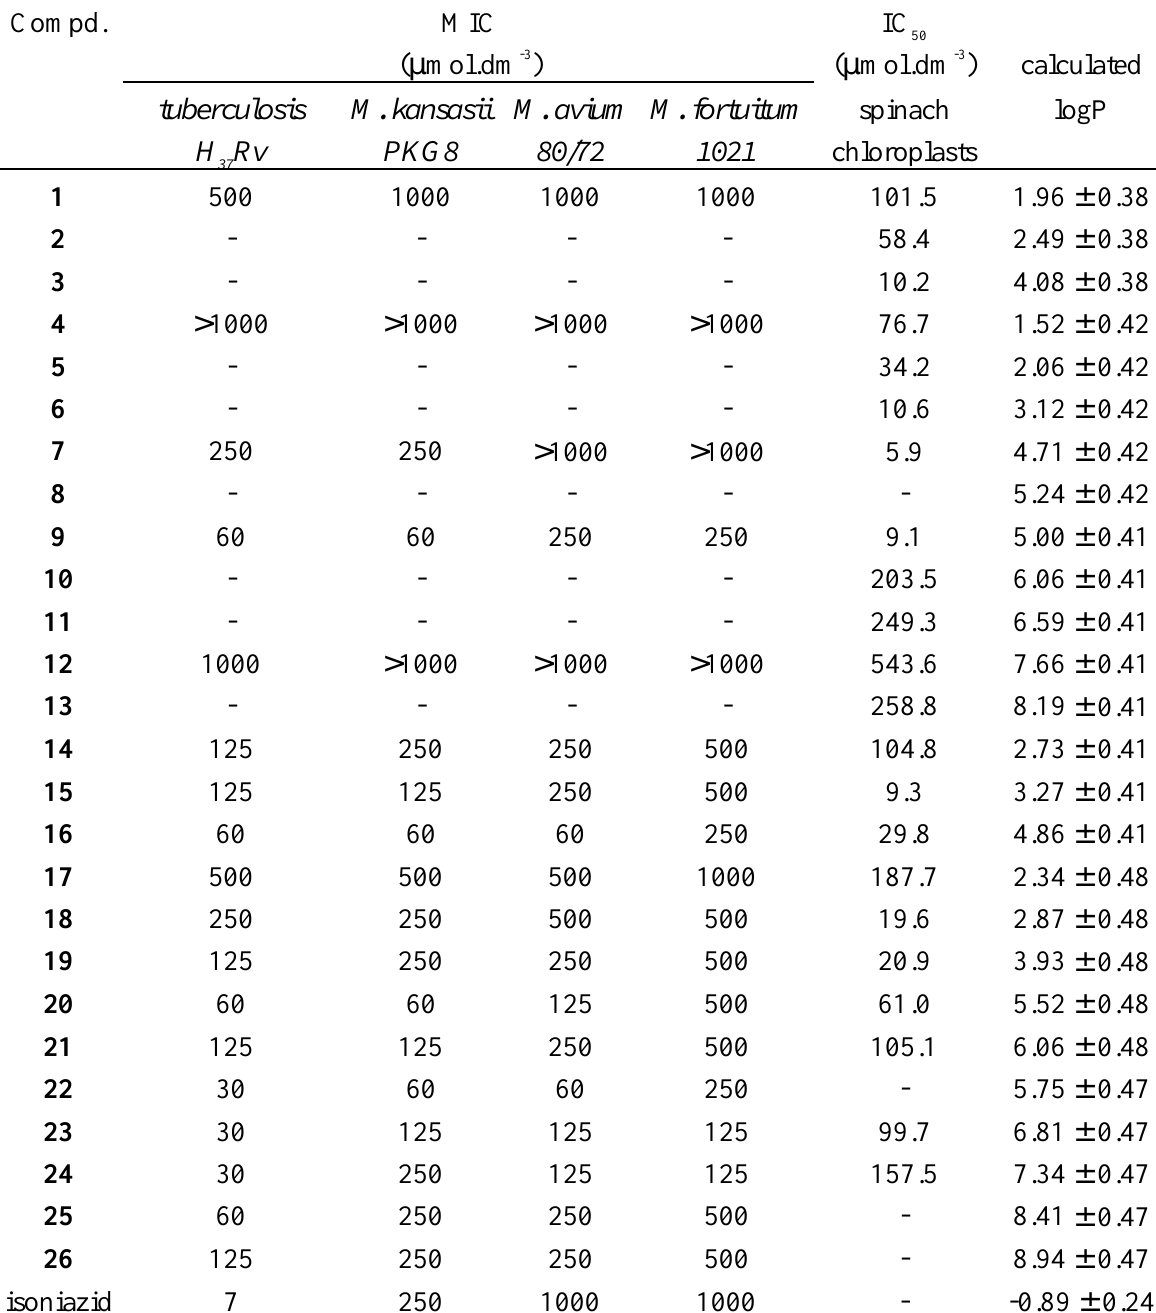
Table 3. MIC of the tested compounds against used mycobacterial strains, IC values concerning inhi- 50 bition of oxygen evolution rate in spinach chloroplasts by the tested compounds and calculated logP values of the prepared